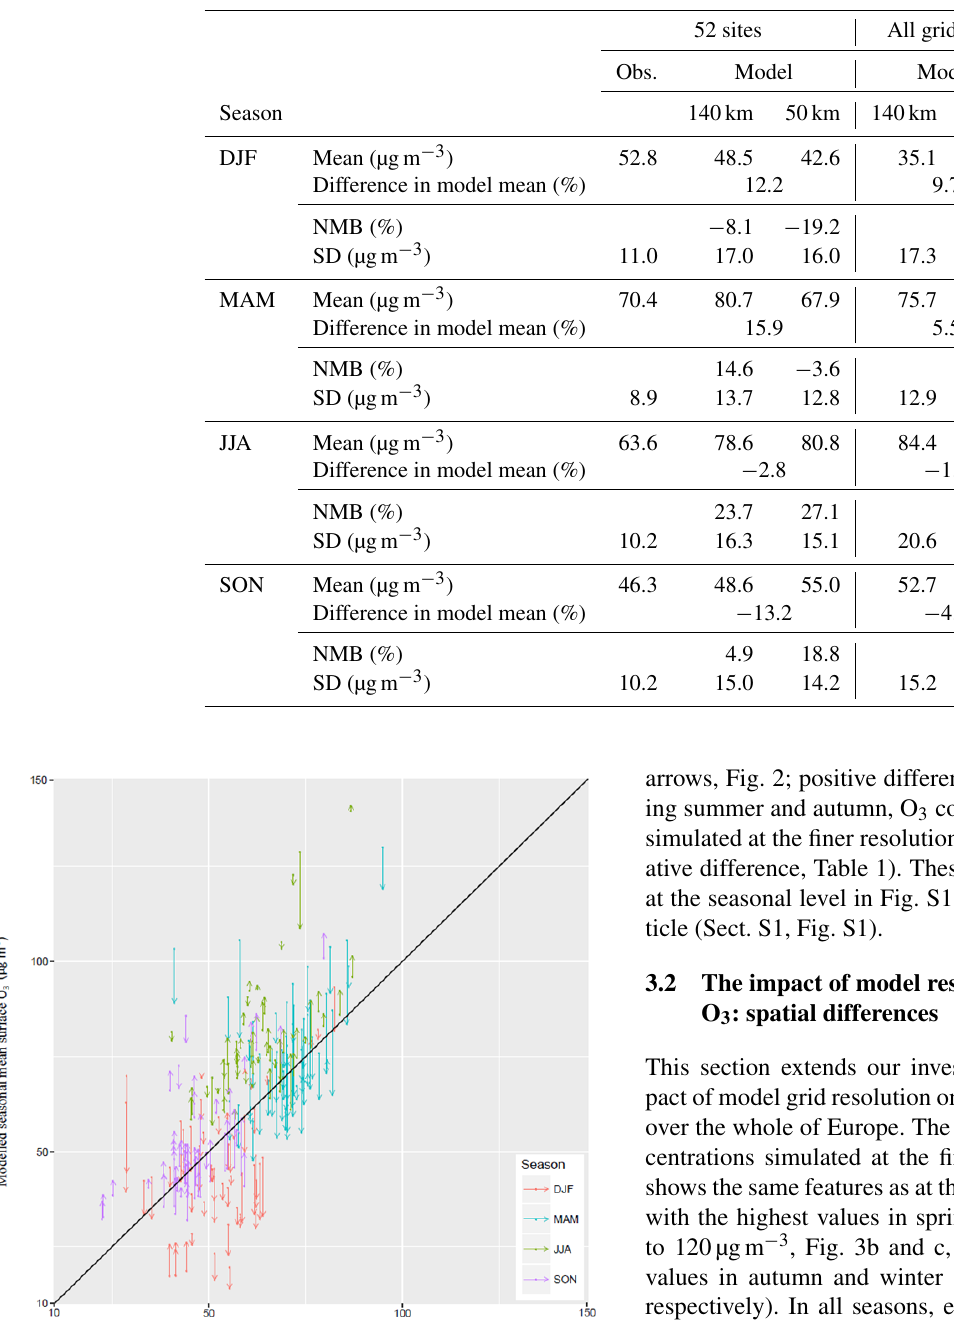
Table 1. Statistical results comparing seasonal mean O 3 concentrations simulated at the coarse and finer resolutions to observations from 52 stations within the EMEP network in 2007. Statistical results for all model grid-cells of both resolutions are also shown. Percentage differences between the two model resolutions are calculated as (O 3 coarse resolution − O 3 finer resolution )/ (O 3 coarse resolution ) .